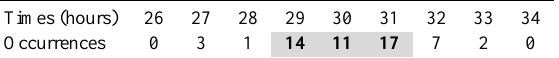
Table 6. Encirclement times.